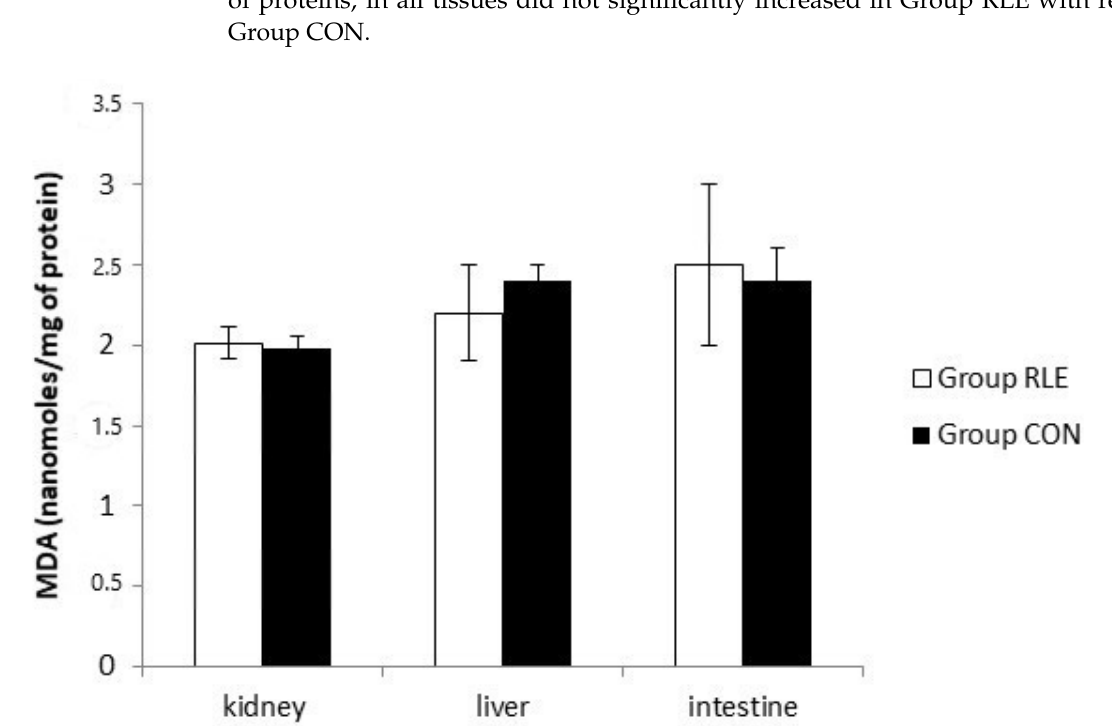
Figure 2. Effects of red orange and lemon extract (RLE) on lipid peroxidation measured by malondialdehyde (MDA) test at the end of treatment. Group RLE (RLE treated group), Group CON (control) untreated group. Results are expressed as mean ± SD.